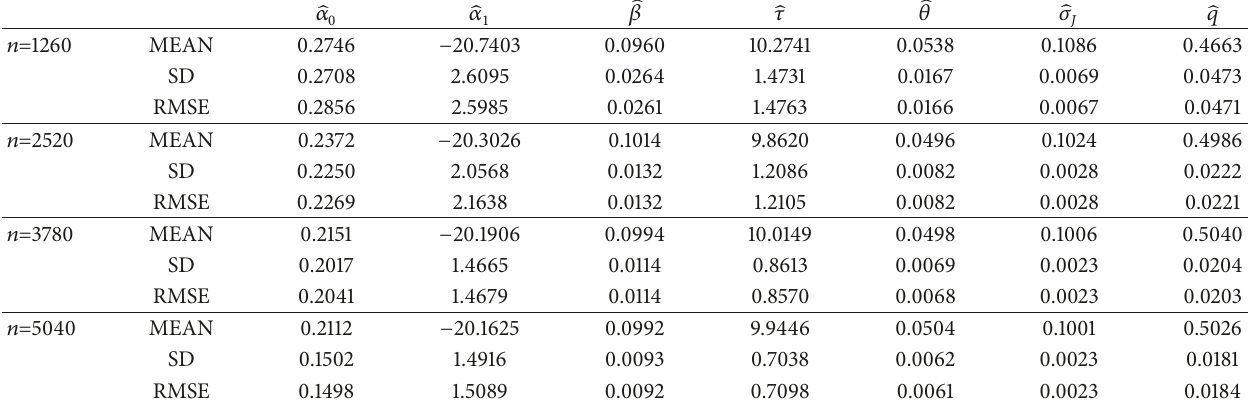
Table 1: Parameters estimate, standard error, and root of mean square error for model (12), where 𝛼 0 =0.2, 𝛼 1 = − 20, 𝛽 =0.1, 𝜏 =10, 𝜃 =0.05, 𝜎 𝐽 =0.1, and 𝑞 =0.5.